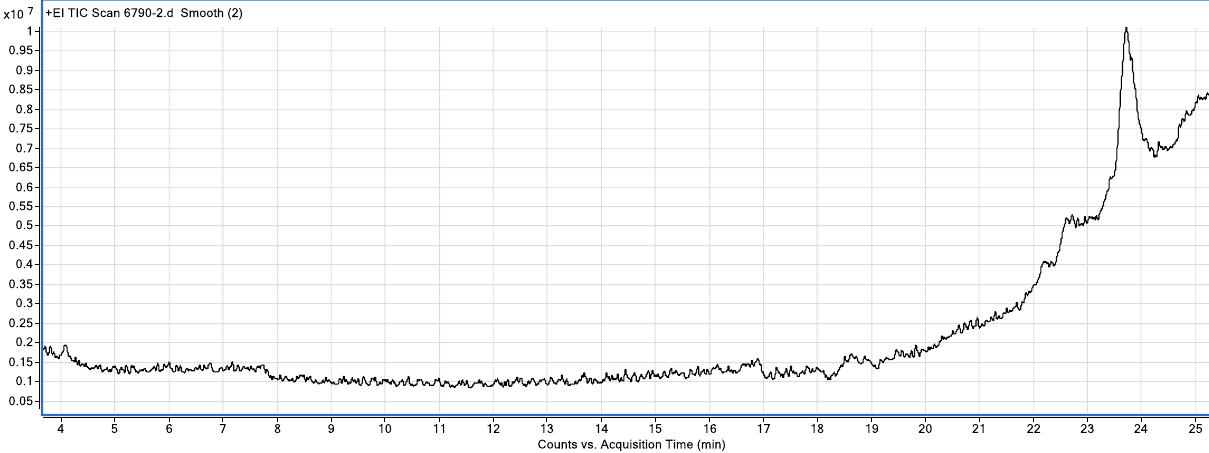
Fig. 3 GC–MS spectra of Congo red after treatment with Aspergillusniger